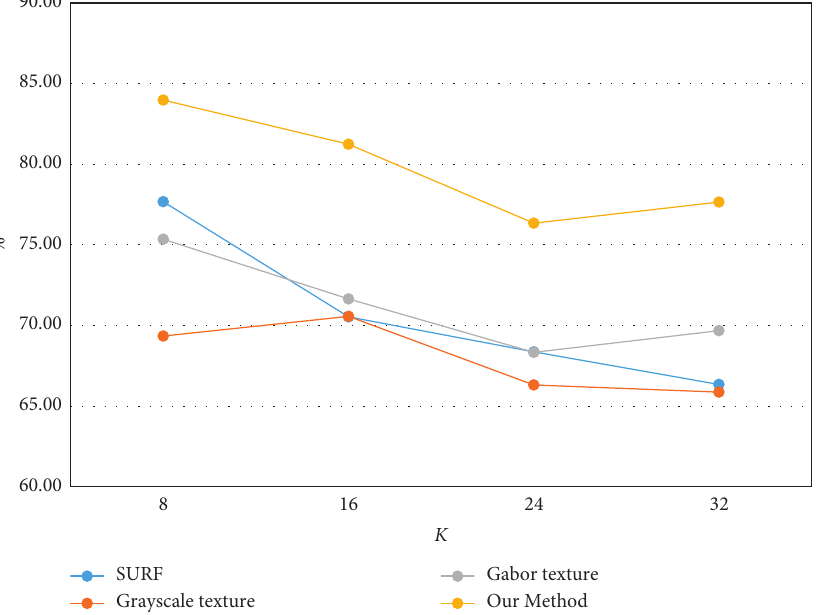
Figure 11: Comparison of features of liver medical